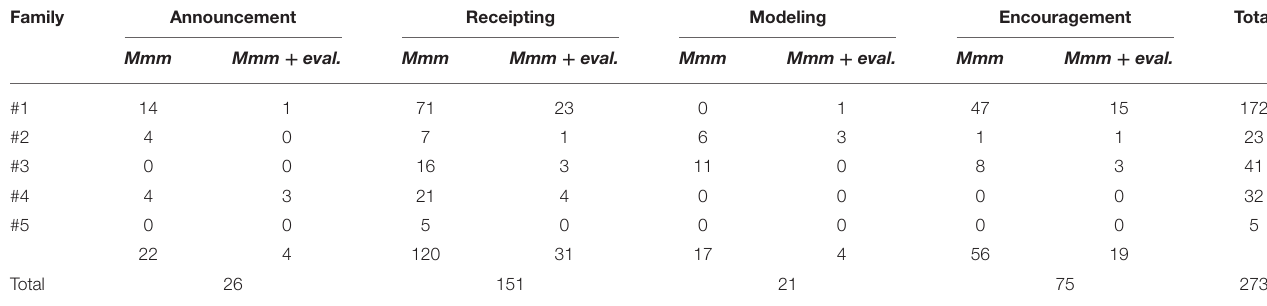
TABLE 2 | Classification of gustatory mmms across the data corpus.